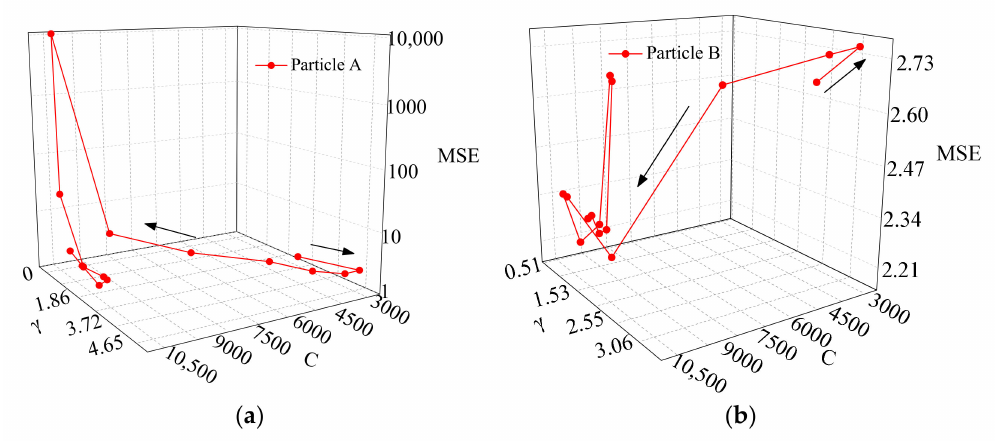
Figure 5. Iterative process of random particles. ( a ): Iterative process of particle A; ( b ): Iterative process of particle B.